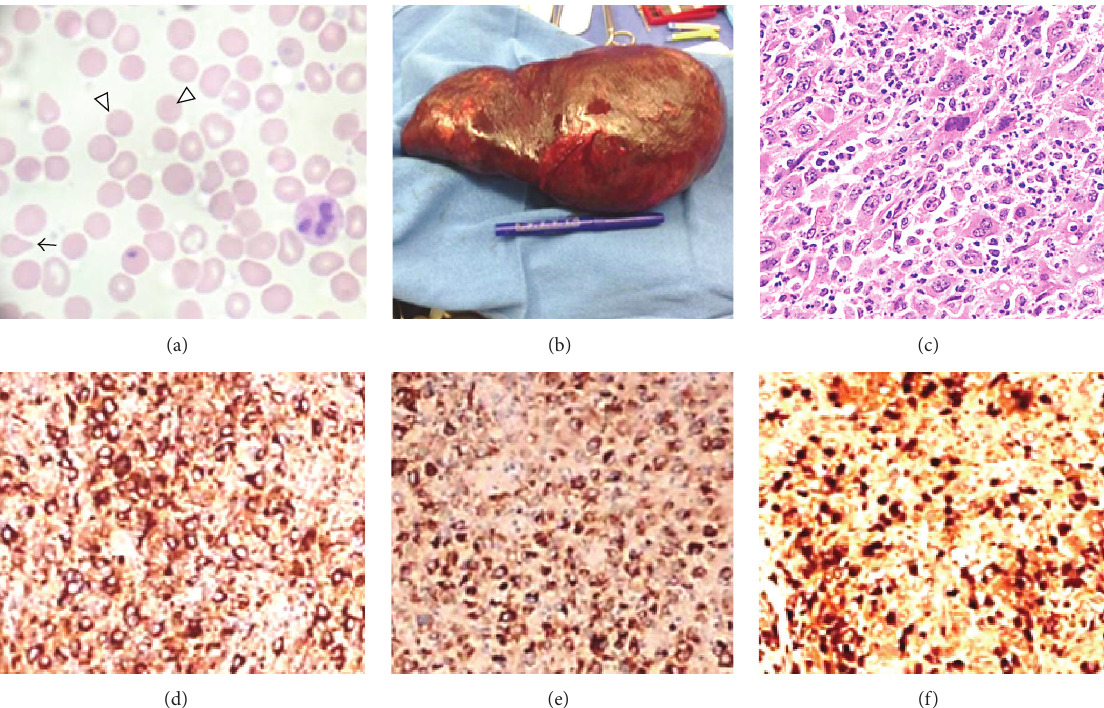
Figure 2: Peripheral blood smear and histopathology of the spleen. (a) Prechemotherapy peripheral blood smear with anisopoikilocytosis, numerous spherocytes (white arrows), tear drop cell (black arrow), and decreased platelets; (b) massively enlarged, surgically removed spleen (weight = 1770 grams; 24 × 14 × 11cm in size); (c) histological sections of the spleen revealed sheets of atypical cells with a high nuclear to cyto- plasmicratio,prominentnucleoli,andanabundanteosinophiliccytoplasm(400xmagnification);(d,e,andf)areasofspleeninvolvedwithHS demonstrated strong and diffuse immunoreactivity with macrophage-specific markers (CD68 PGM (d), CD68 KP1 (e), and lysozyme (f)) [7].